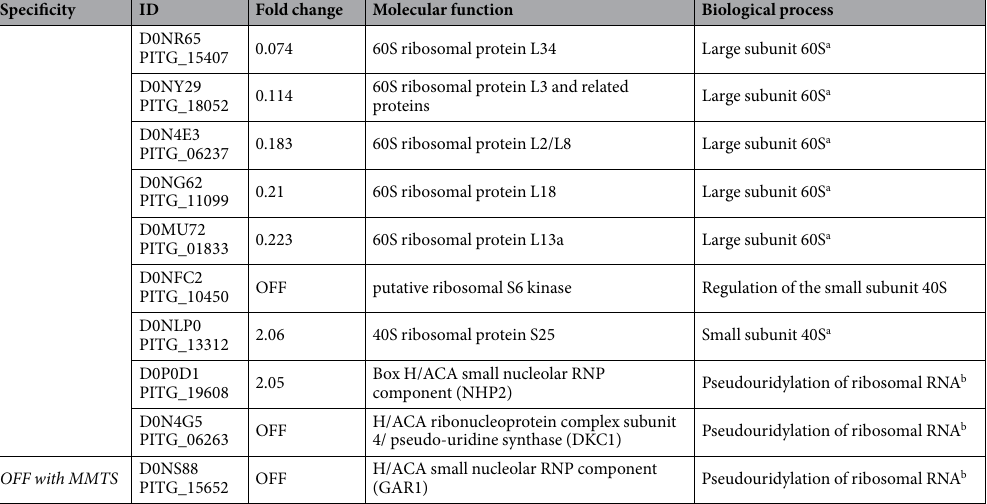
Table 1. BMTMS-regulated proteins involved in ribosomal function. a KEGG pif03010: Ribosome. b KEGG pif 03008: Ribosome